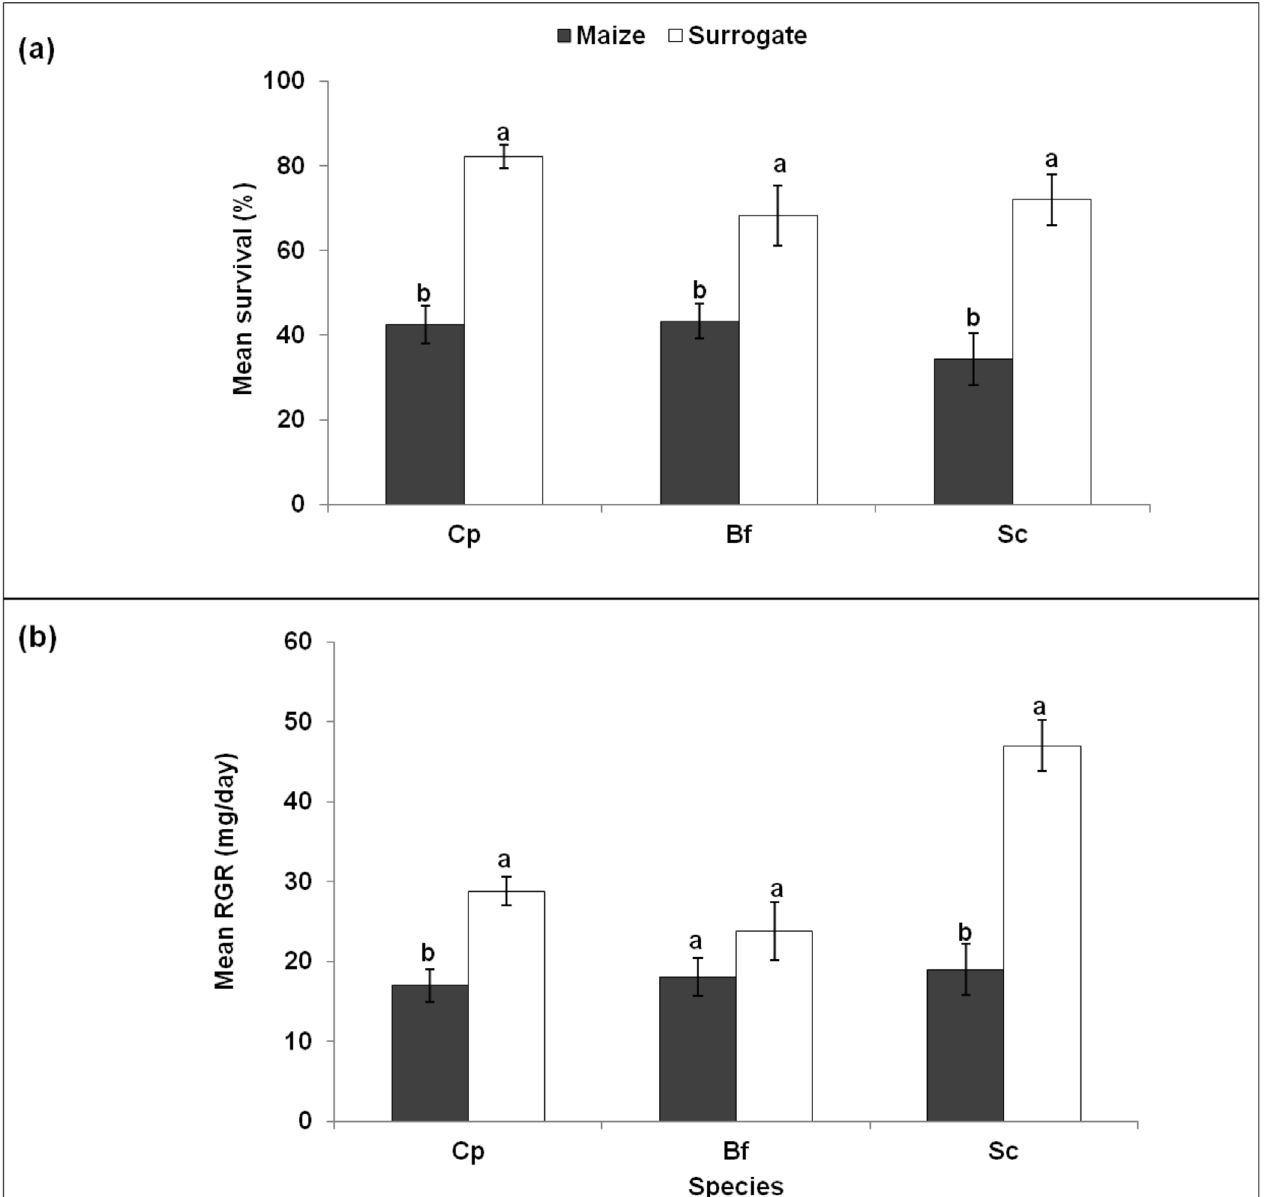
Fig 2. Survival (a) and relative growth rates (b) of Chilo partellus (Cp), Busseola fusca (Bf) and Sesamia calamistis (Sc) larvae on maize and surrogate stems under varying temperatures. Means ( ± SE) with different letters are significantly different at 5% level according to the GLM for survival and the Student-Newman-Keuls test for relative growth